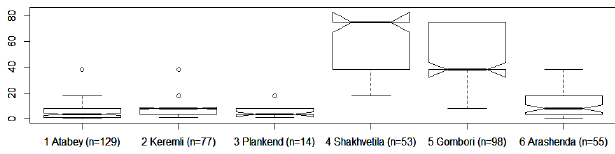
Fig. 9 . Box-and-whisker plots of “Cover of erosion tracks” on 100 m² in percent.